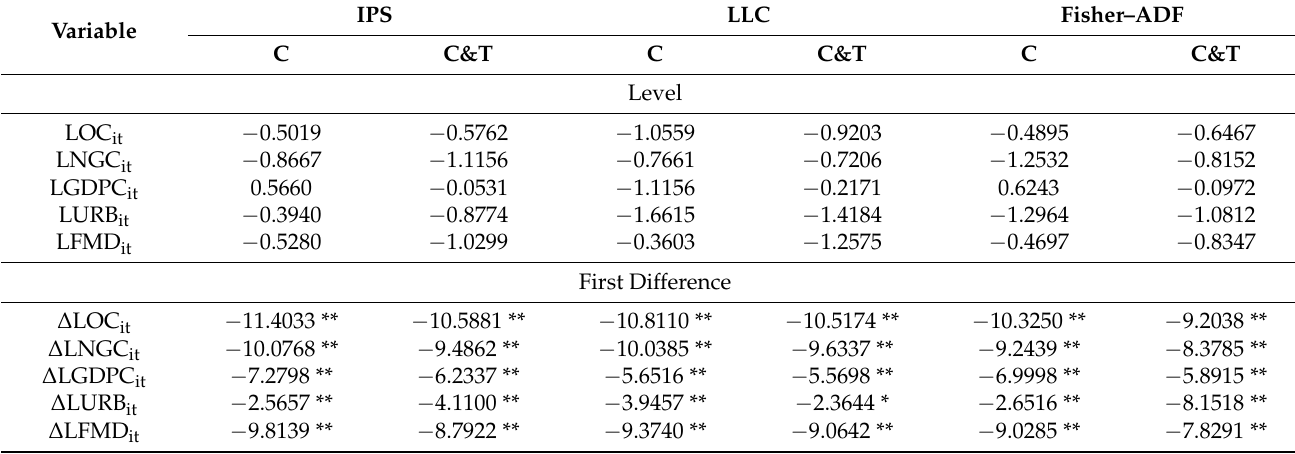
Table A1. Panel unit root test.